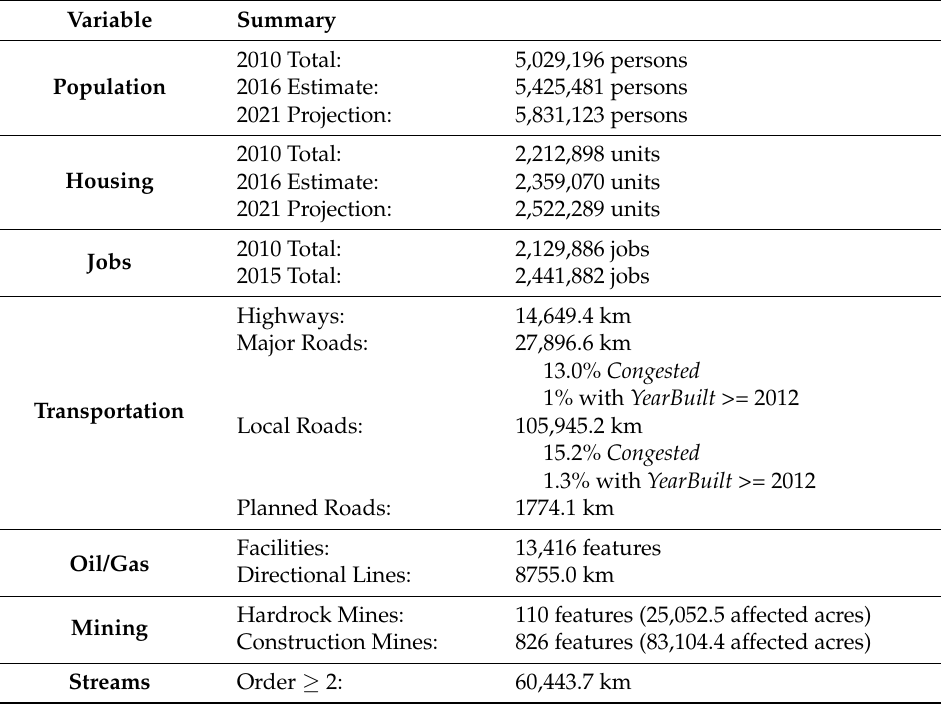
Table 2. Selected summary of demand-related data.